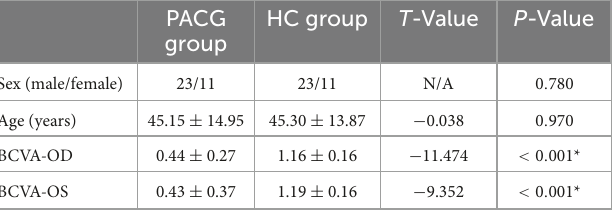
TABLE 1 Clinical characteristics for health controls (HCs) and patients with primary angle-closure glaucoma (PACG).